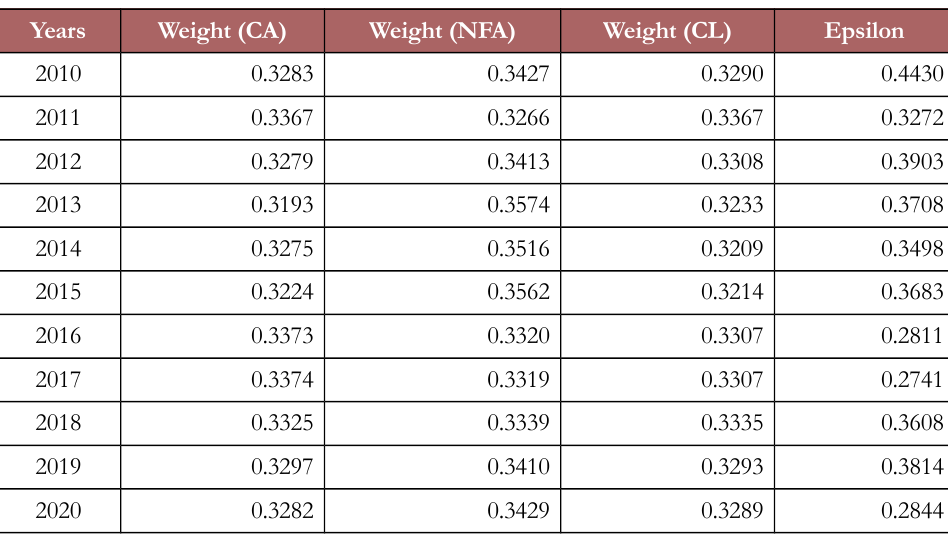
Table 5. Weight of input/output and epsilon from 2010 to